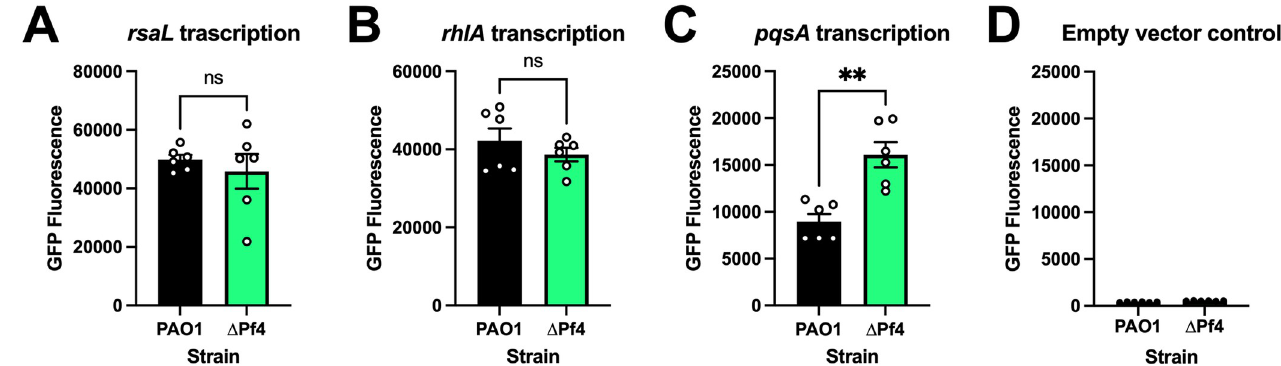
Fig 3. PQS quorum sensing is upregulated in P . aeruginosa Δ Pf4. GFP fluorescence from the transcriptional reporters ( A ) P rsaLI -gfp , ( B ) P rhlA -gfp , ( C ) P pqsA - gfp and ( D ) P empty -gfp was measured in PAO1 (black) or Δ Pf4 (green) at 18 hours in cultures growing in lysogeny broth. For each measurement, GFP fluorescence was corrected for bacterial growth (OD 600 ). Data are the mean ± SEM of six replicates. �� P < 0.001, Student’s t